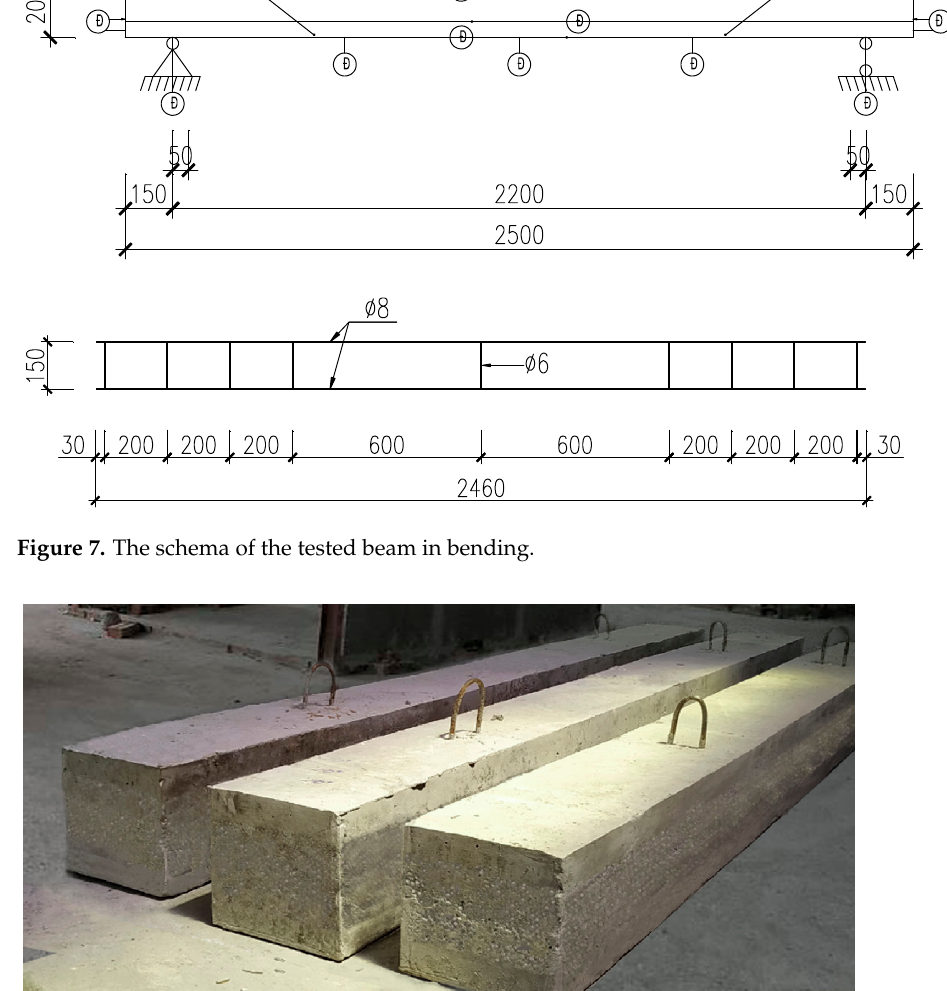
Table 4. Strength and deformative characteristics of concrete in experimental beams. N o of